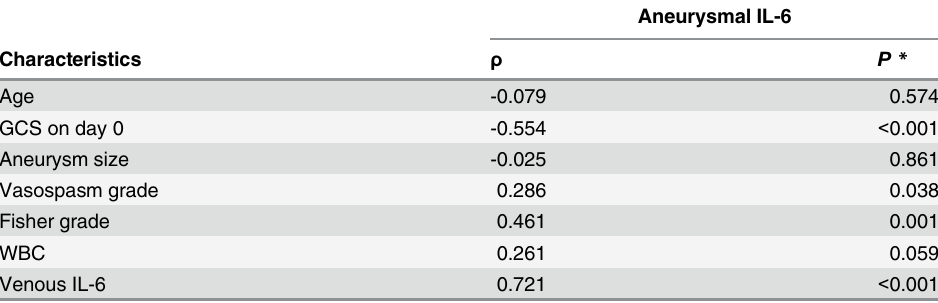
Table 2. Correlations between aneurysmal IL-6 level and other